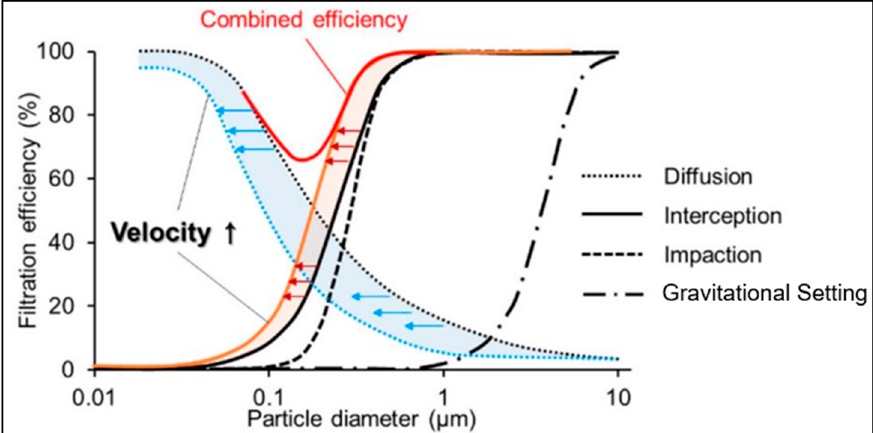
Figure 1. Illustration of the combined effects of the particle capture mechanisms for solid particles on the overall filtration efficiency [12].